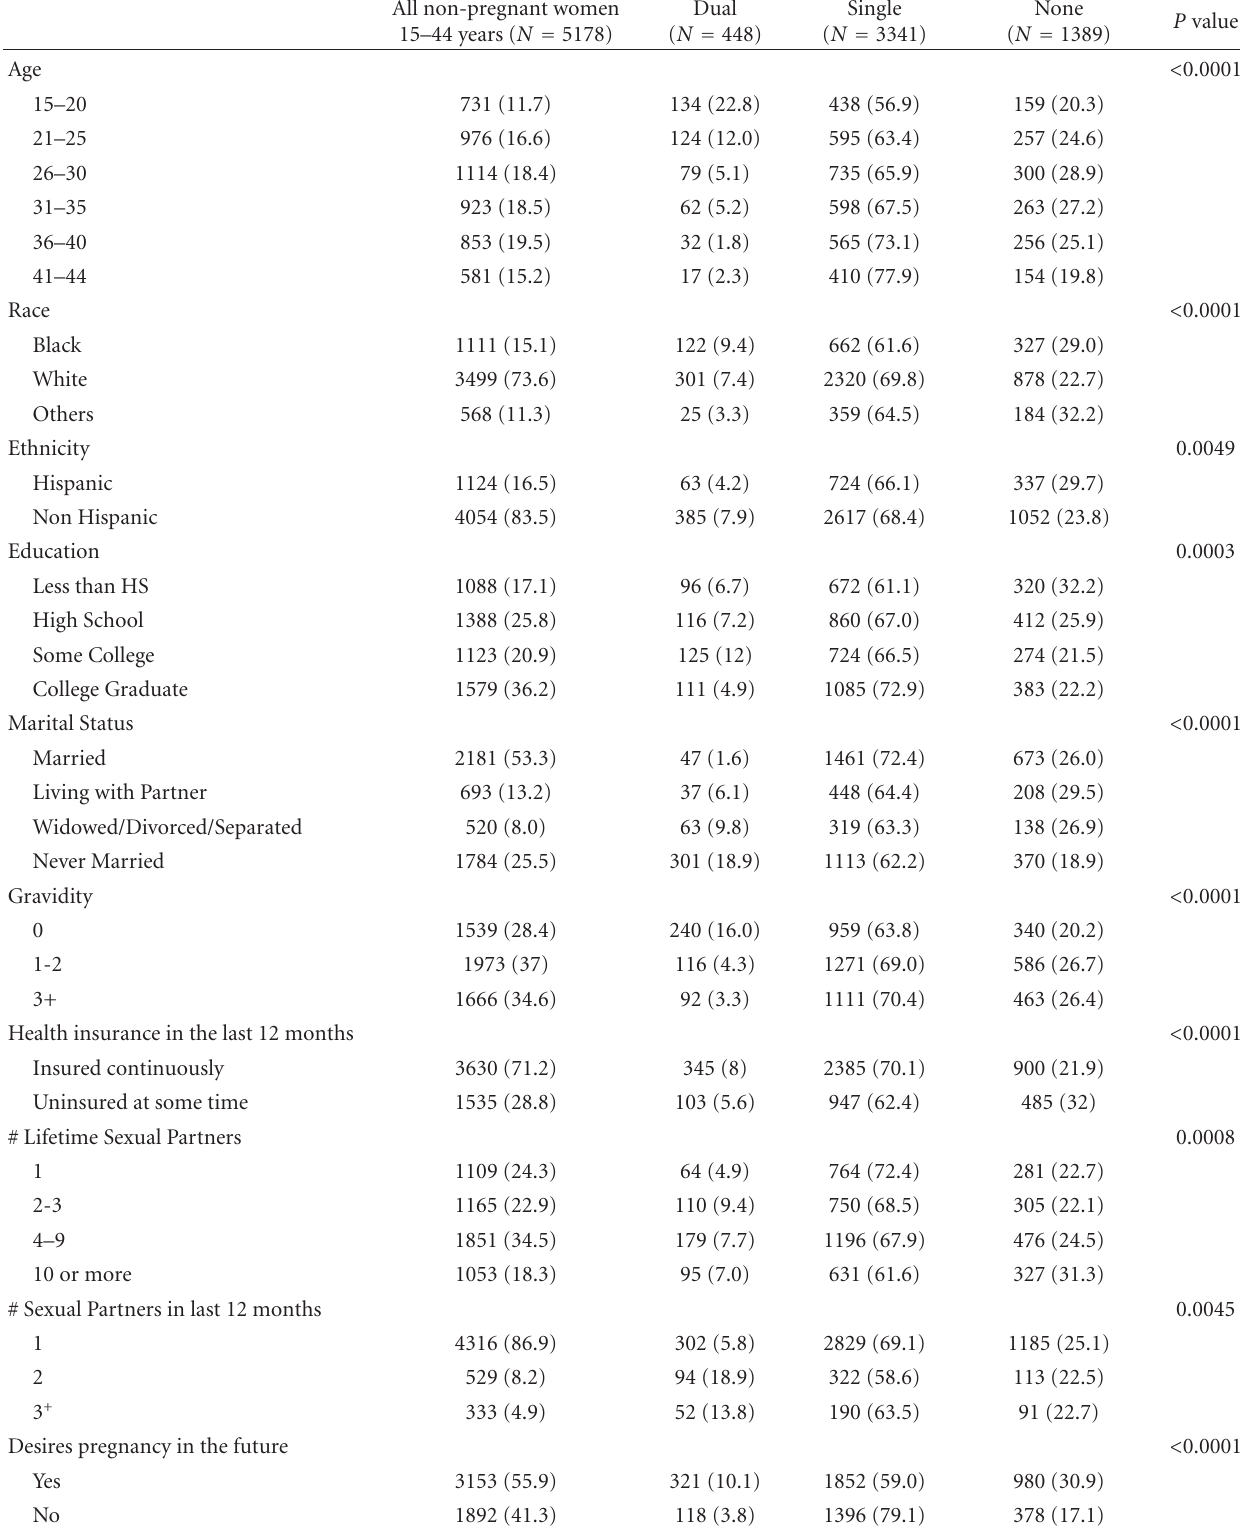
Table 2: Summary of participants’ characteristics by number of methods